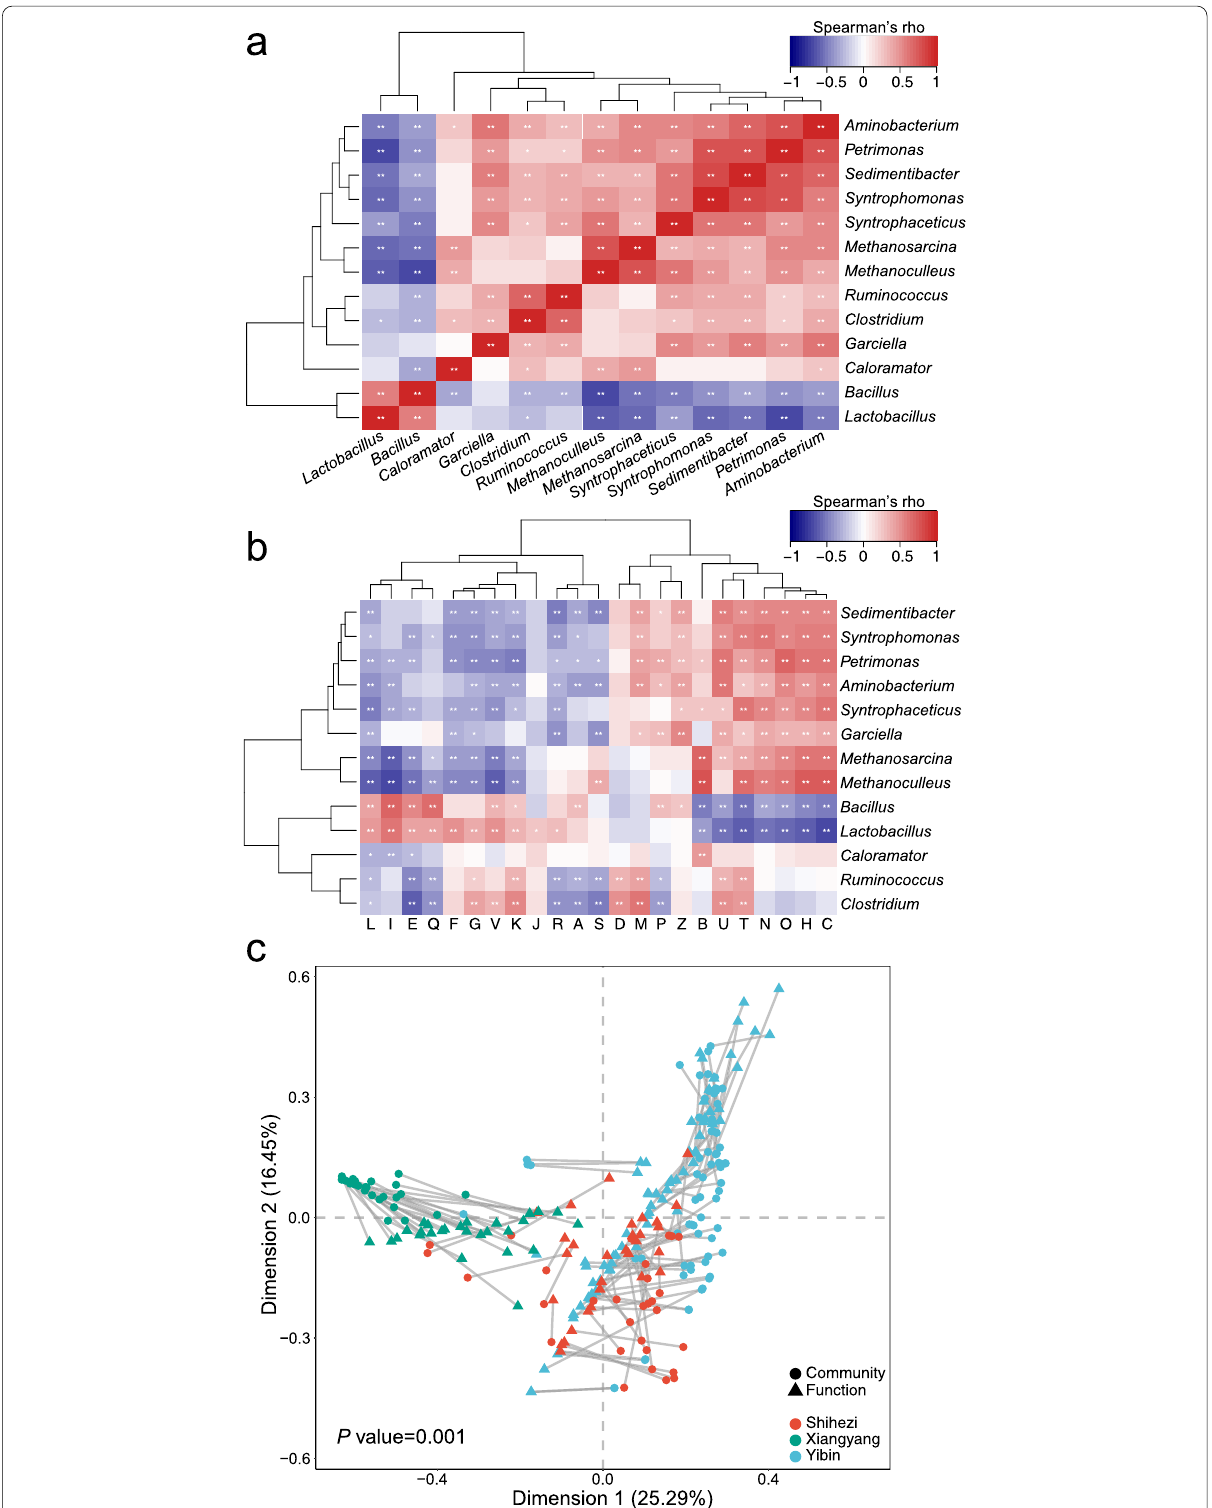
Fig. 6 Spearman’s correlation between the main bacteria in pit mud samples ( a ) and between bacteria and COG functional categories ( b ). Procrustes analysis of the correlation between microbial community and functional profiles ( c ). Significant differences are illustrated with ** P < 0.01 and *0.01 P < ≤